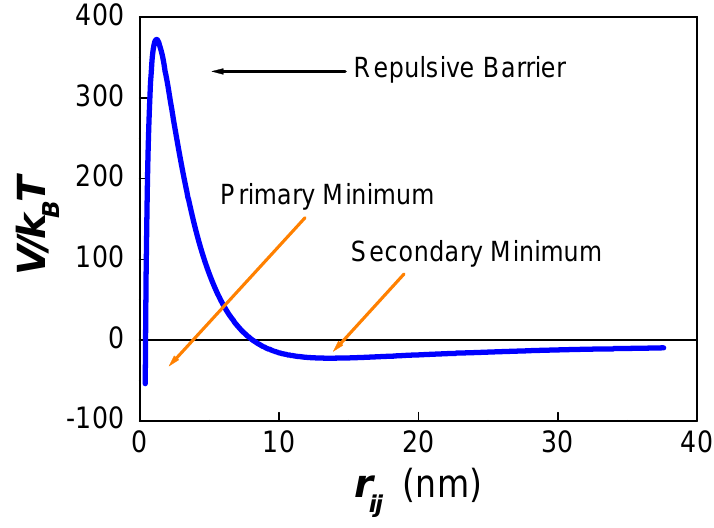
Figure 1. Classical DLVO potential. The curve corresponds to the interaction potential between two 3.9- μ m drops of dodecane ( A are partially covered with sodium dodecyl sulfate ( C homogeneous surfactant distribution (Section